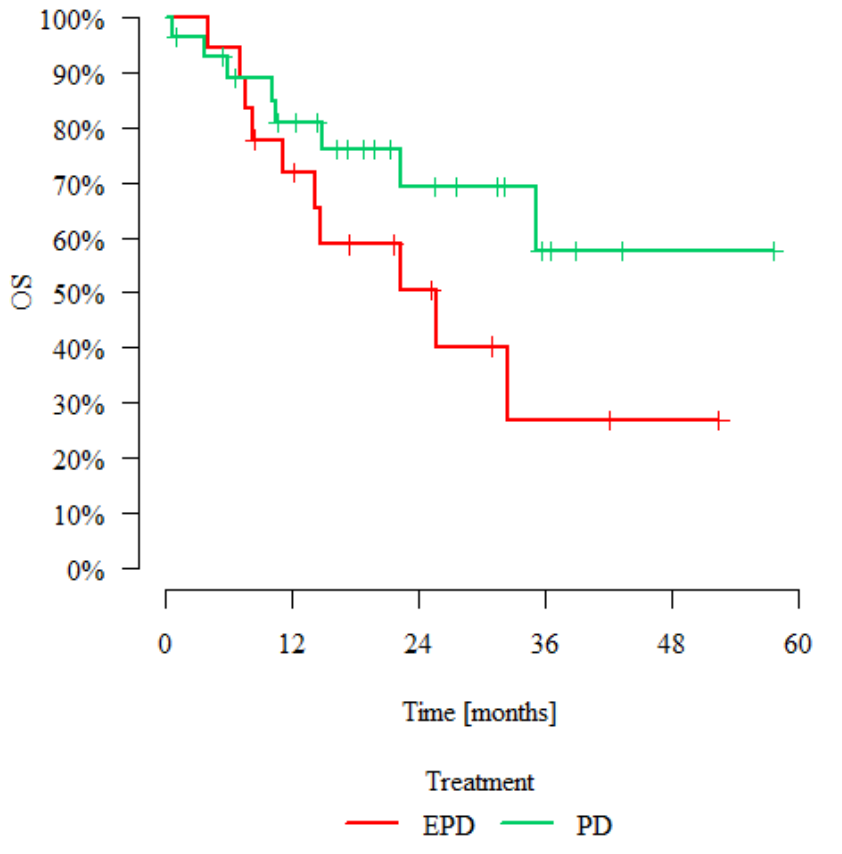
Figure 2. Kaplan–Meier Curve. OS indicates overall survival. Table 4. Overall Survival. EPD indicates extended pleurectomy/decortication; PD, pleurectomy/